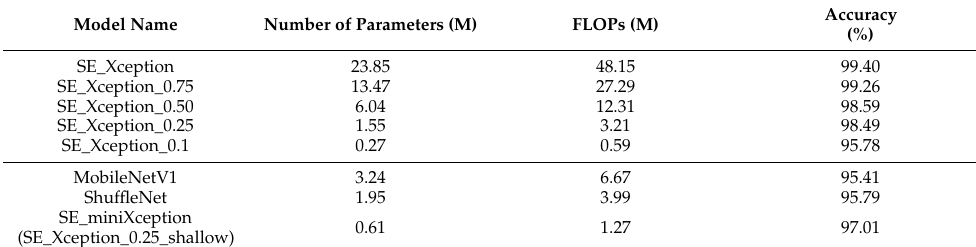
Table 3. Comparison of compressed SE_Xception and other light-weight